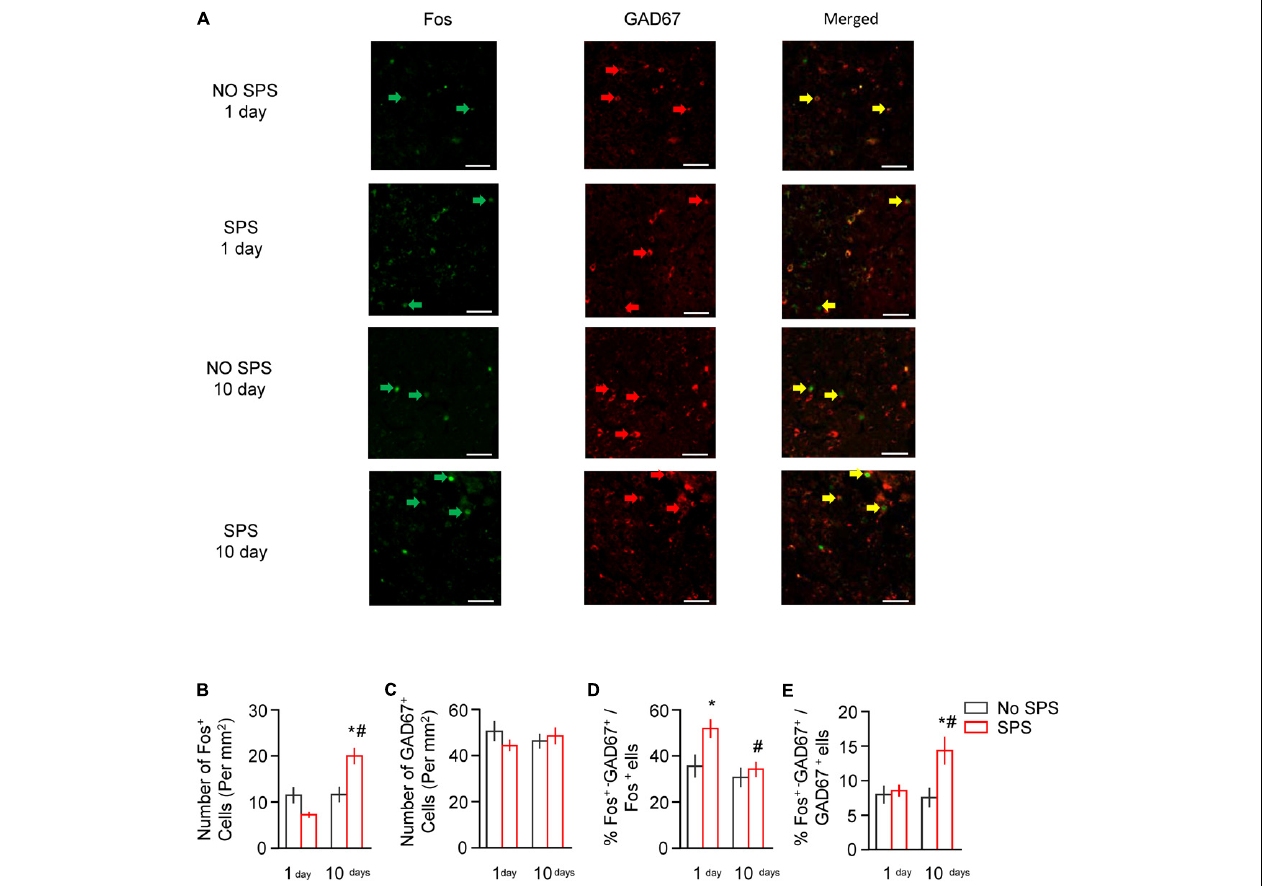
FIGURE 3 | Effect of single prolonged stress (SPS) on activation of GABAergic neurons in BLA on day 1 or day 10 after stress. (A) Representative images showing green (Fos protein), red GAD67 protein), and merged channels of double-label neurons in BLA in different experimental conditions. Scale bars represent 100 µ m. (B,C) Effect of the experimental manipulations on Fos protein (B) and GAD67 expression (C) in BLA. (D) Percentage of GABAergic neurons in activated cells of BLA in different experimental manipulations, as calculated by number of overlap (Fos + GAD67 protein-IR)/Fos-IR. (E) Percentage of activated cells in GABAergic neurons in different experimental manipulations, as calculated by number of overlap (Fos + GAD67 protein-IR)/GAD67-IR. n = 6–7 per group. Data are mean ± SEM. ∗ Different from no SPS group at each post-stress day. # Different from SPS-1 day group, one-way ANOVA, p <